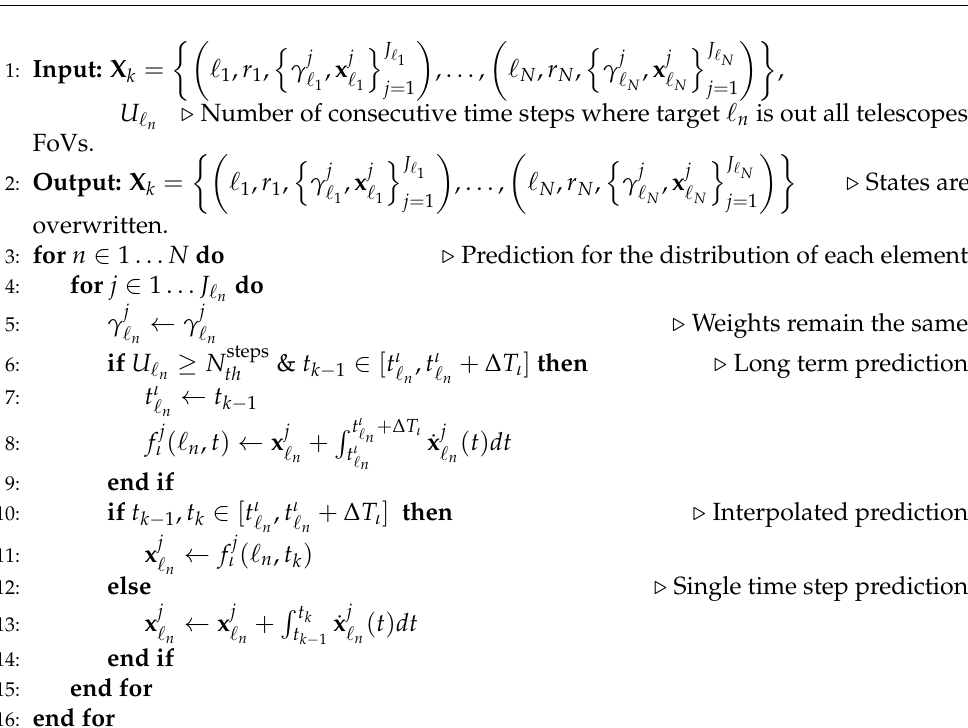
Algorithm 1 Prediction Step